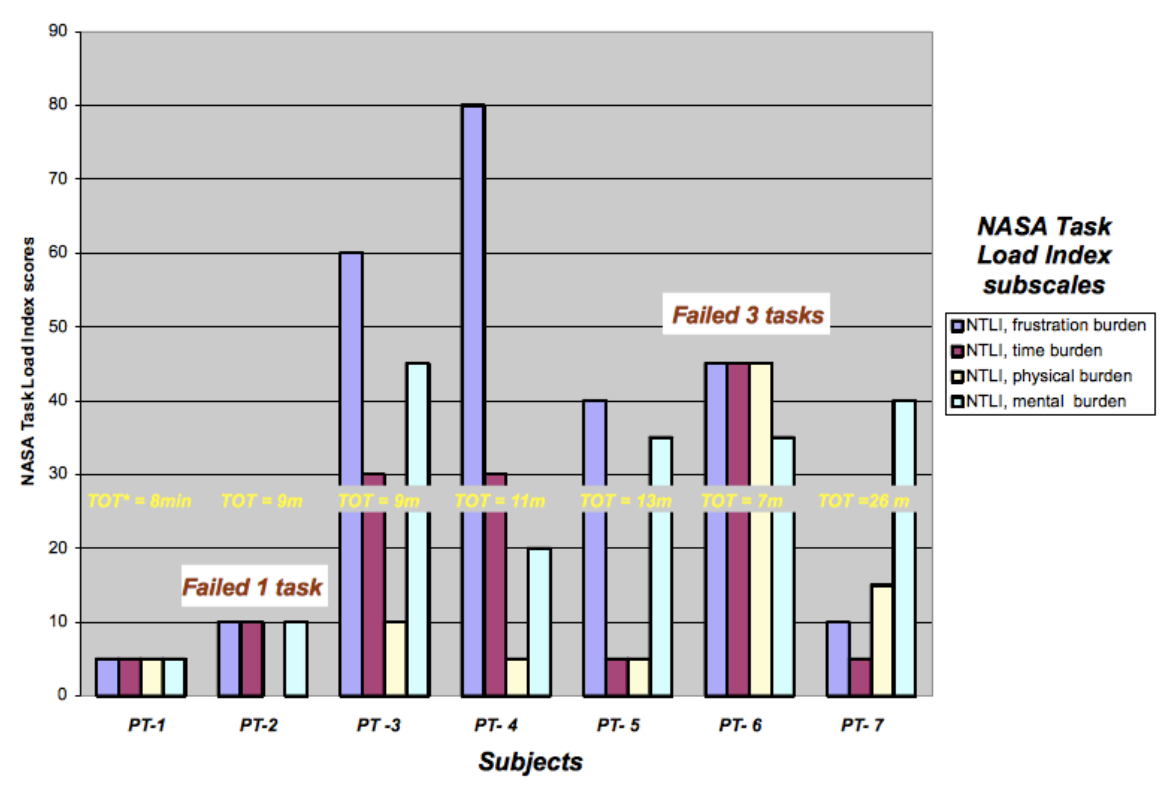
Figure 4. Task burden experienced and time on task (TOT) spent by subjects while they attempting to complete the 3 tasks during the